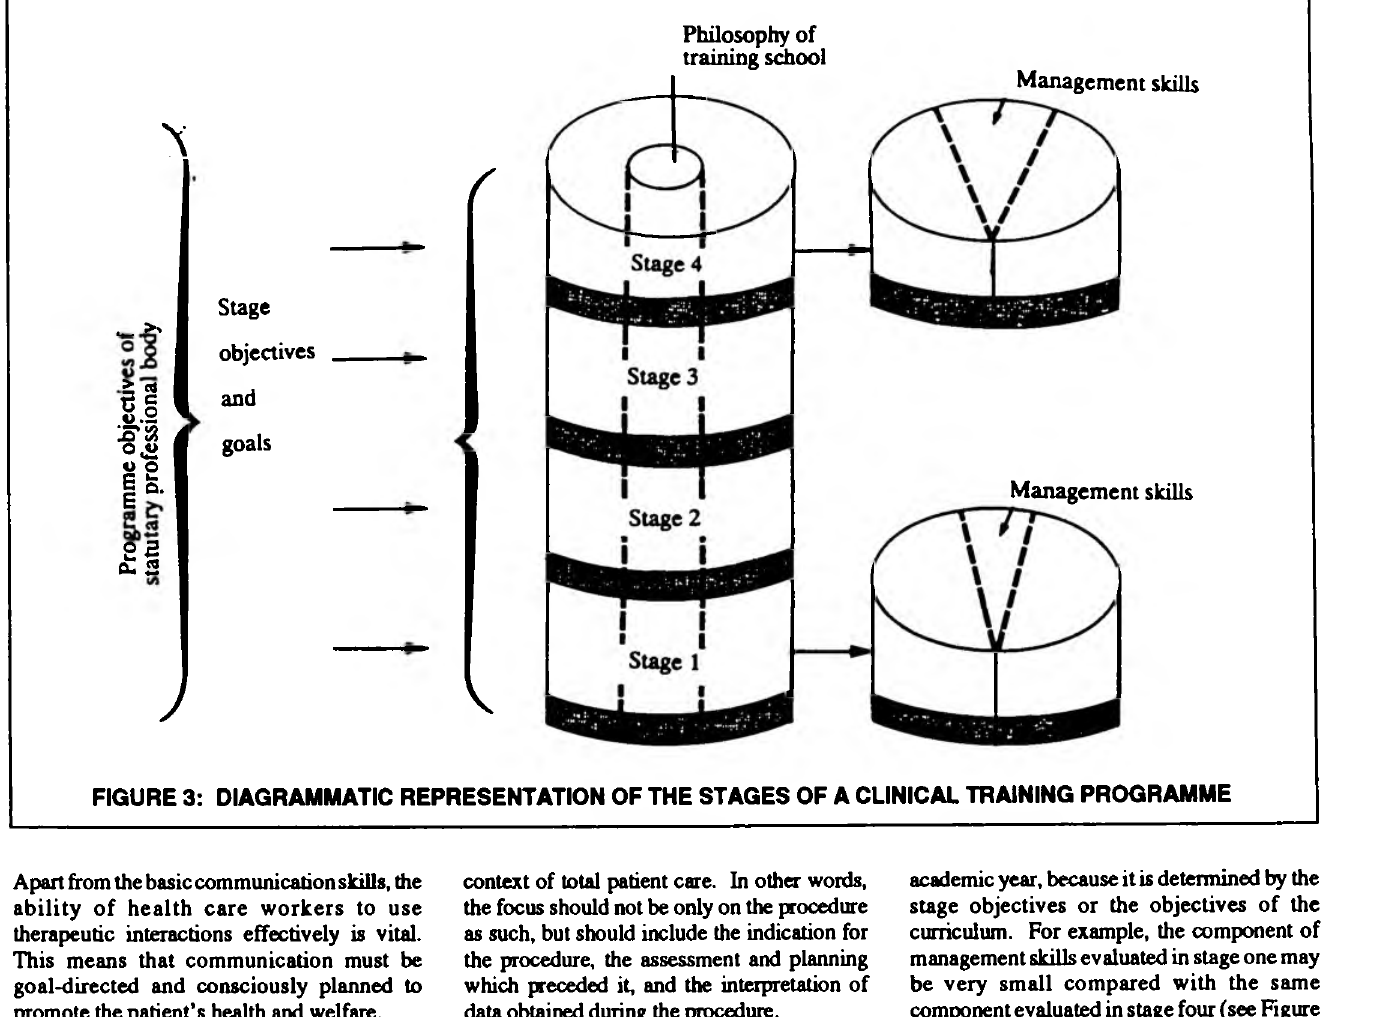
Apart from the basic communication skills, the ability of health care workers to use therapeutic interactions effectively is